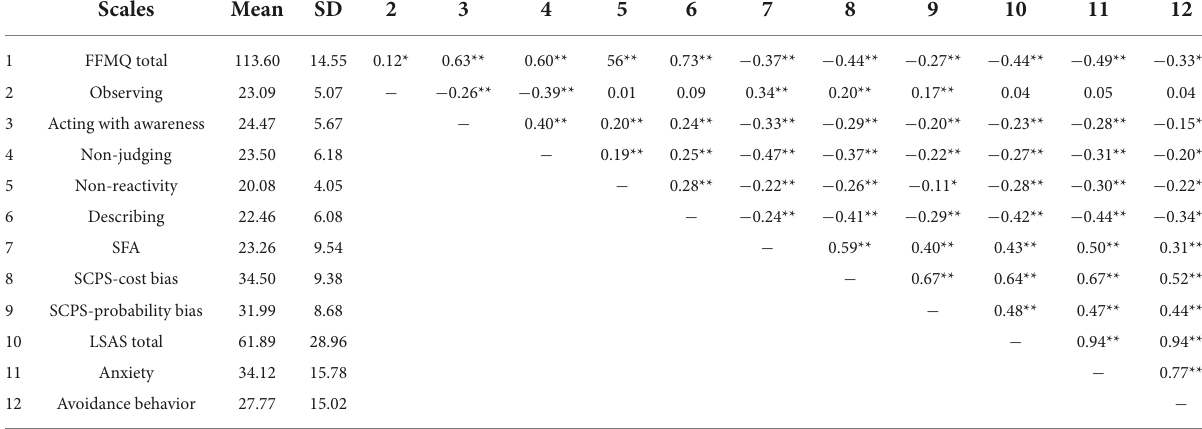
TABLE 2 Descriptive statistics and correlations among the scales.